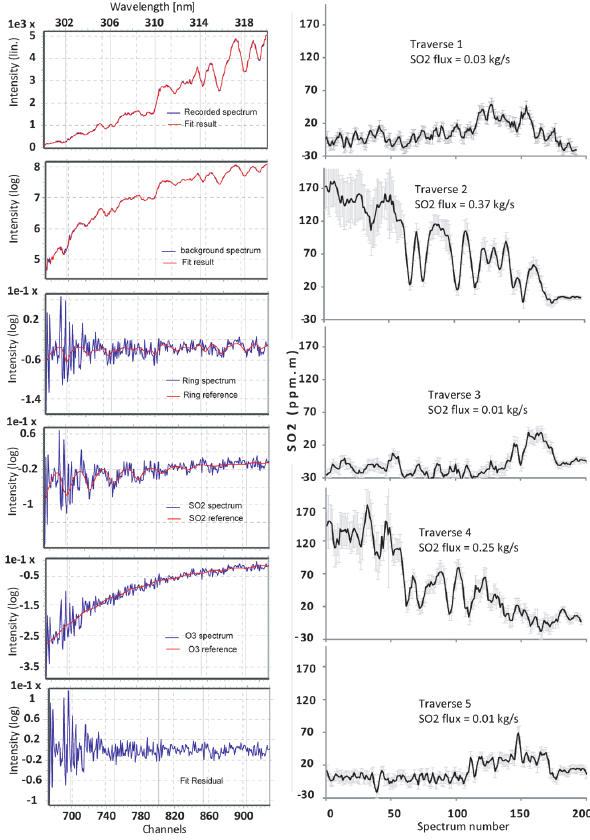
Fig. 5. Example of DOAS SO 2 fit on Bromo (left). Measurement spectra are blue. Traverse measurement profiles are shown (right). Traverses 1, 3 and 5 did not catch the bulk concentration while tra- verses 2 and 4 commenced in the plume (see